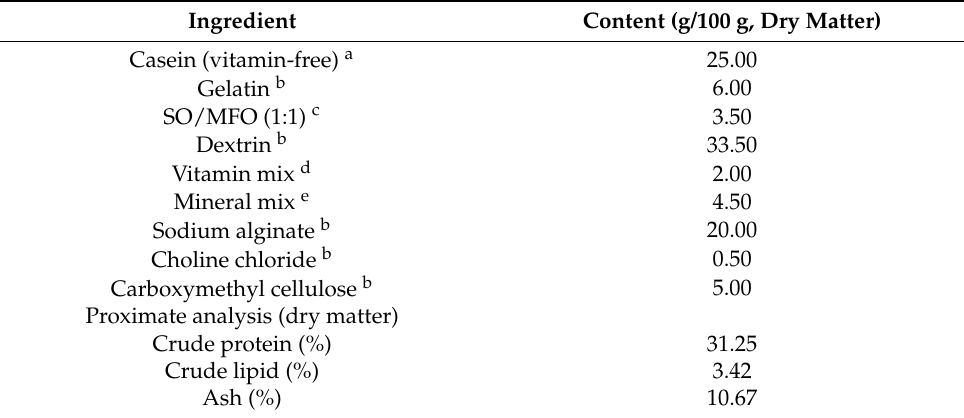
Table 1. Formulation and proximate compositions of the basal diet. Ingredient Content (g/100 g, Dry Matter) Casein (vitamin-free) a